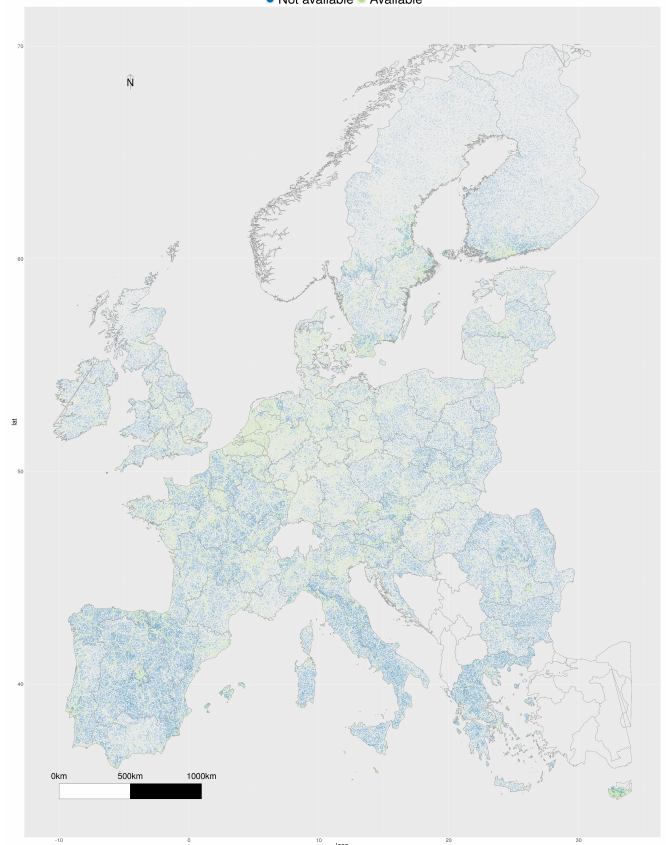
Figure 4. Map displaying the LUCAS 2018 survey points. To assess the availability of Mapillary crowdsourced steet-level imagery, the location with a crowdsourced image closest to each of the 337,031 LUCAS points was harvested through the Mapillary API. The LUCAS points for which an image was available within a 2 km distance are represented in green (N = 127,346 representing 37.78% of the total) while the points without a crowdsourced image within a 2 km buffer are represented in blue (N = 209,492 representing